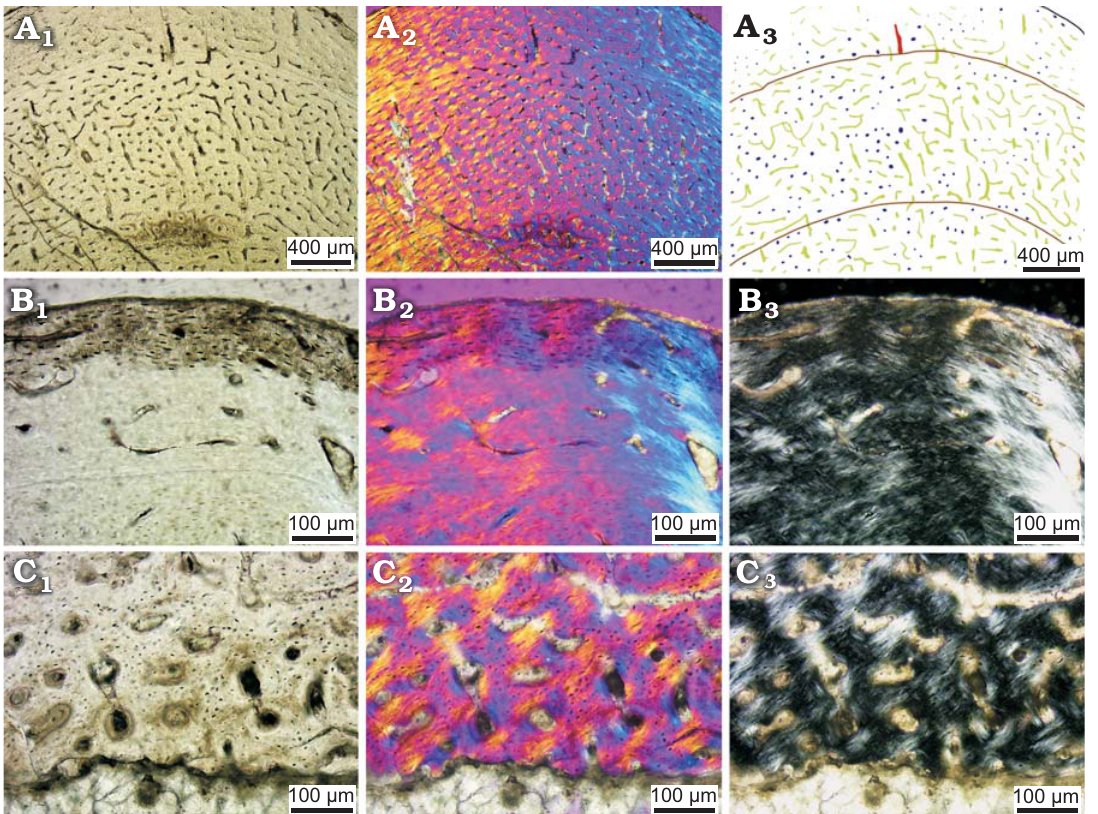
Fig. 3. Bone microstructure in juvenile ceratopsian dinosaur Psittacosaurus lujiatunensis Zhou, Gao, Fox, and Chen, 2006 (IVPP V14341.1) from west- ern Liaoning, China, Early Cretaceous. A – C . Mid-diaphyseal transverse section of right tibia ( A ), the outer most cortex ( B ), the inner most cortex ( C ); photographs in regular transmitted light (A 1 –C 1 ), elliptically polarized light (A 2 –C 2 ), crossed plane-polarized light (B 3 , C 3 ); line drawing (A 3 ) showing longitudinal vascular canals (navy), reticular vascular canals (green), radial vascular canals (red), and LAGs (brown